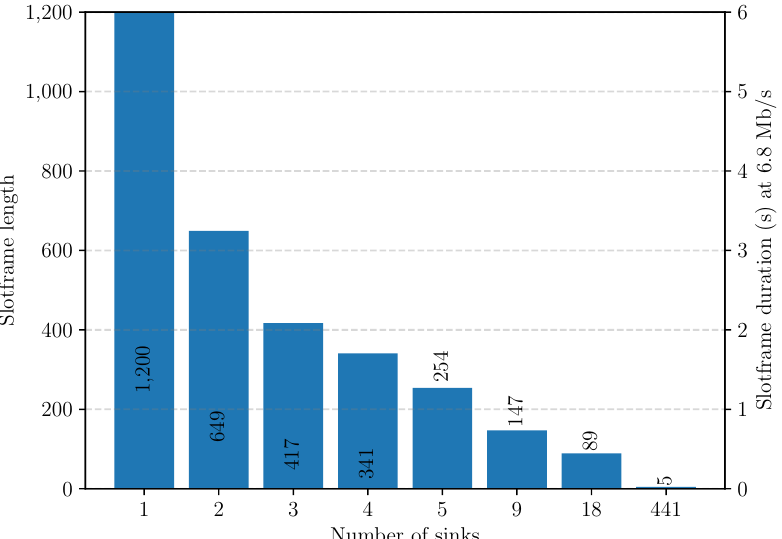
Figure 27. Slotframe length as a function of the number of sinks. Scenarios with a 400 cells network, using 8 channels.